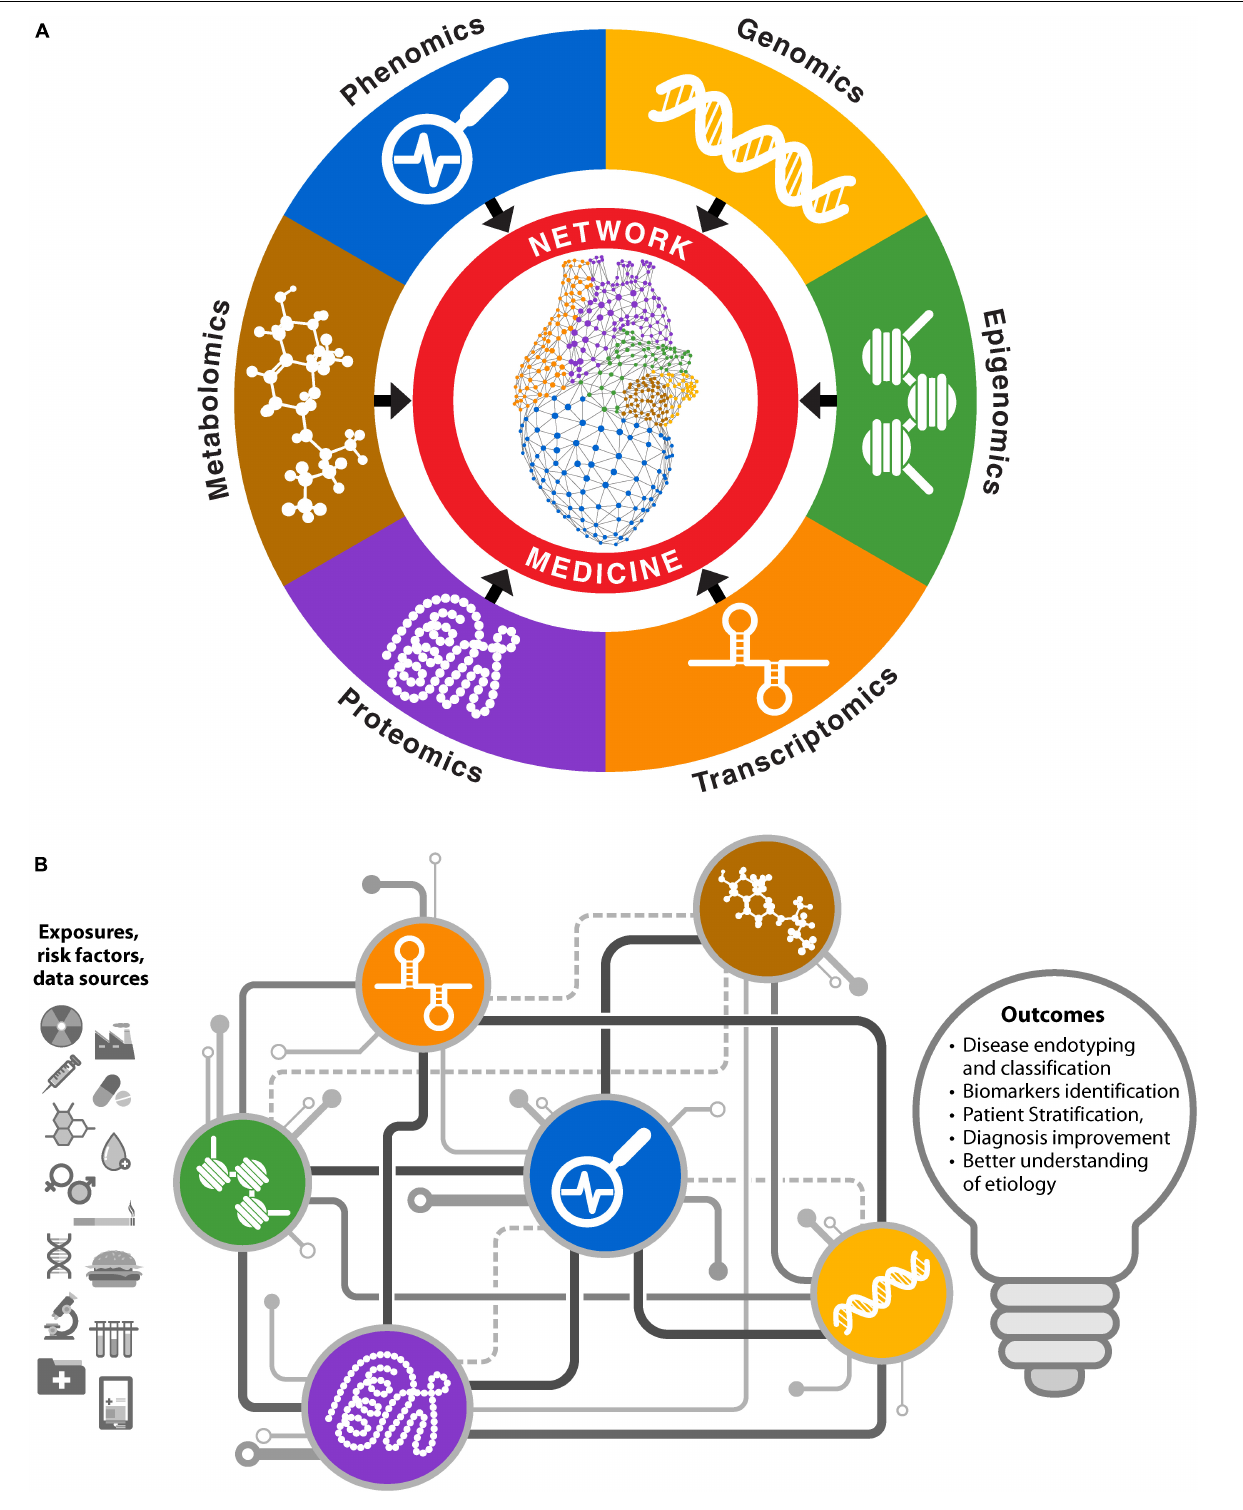
FIGURE 3 | Network medicine approaches for multiomics biomedical data integrations. (A) Networks for individual omics types are constructed and analyzed separately. Information from each omics layer is aggregated to obtain biological insights. (B) Integrative approach where different omics data are used to infer interactions between various biomolecules. Different types of biomolecules from an omics platform are connected in coherent network structures, facilitating information exchange through mechanisms like message passing.